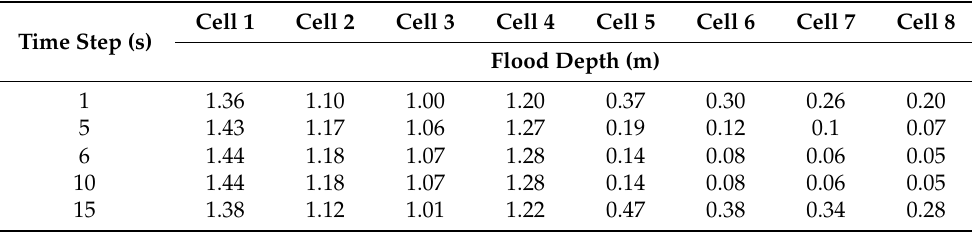
Table 2. Maximum flood depth values in different cells for certain time steps in sub-reach K6. Cell1 Time Step (s)